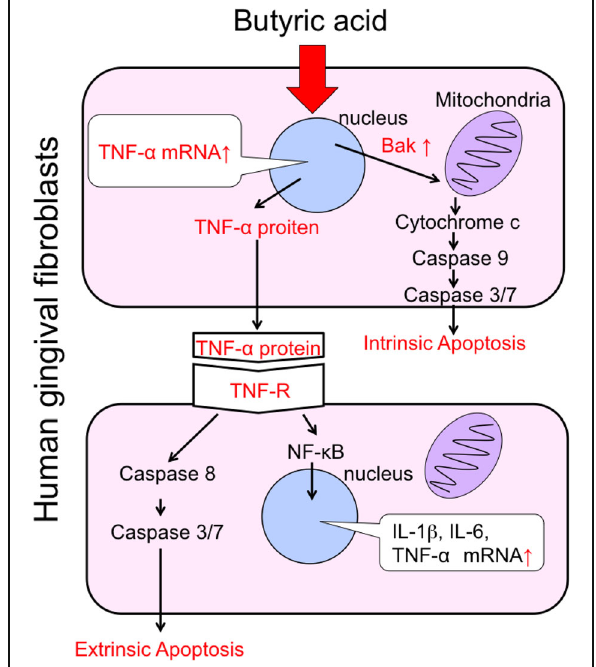
Fig. 1 Intrinsic and extrinsic apoptosis pathway. Adapted and partially modified from